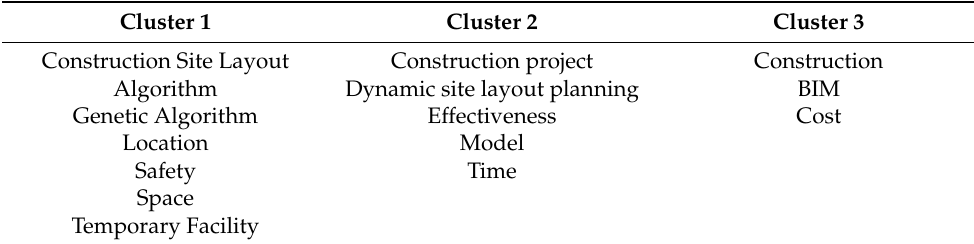
Table 1. Word Occurrences in